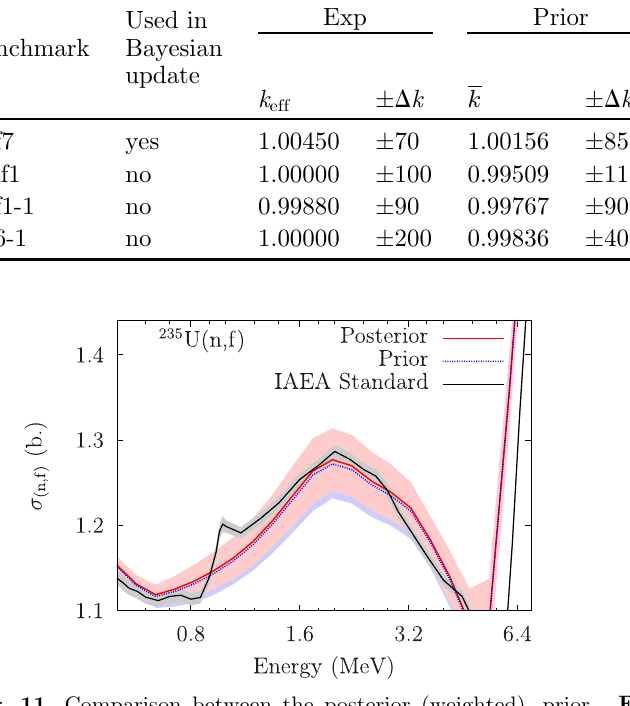
Fig. 11. Comparison between the posterior (weighted), prior (unweighted) and the IAEA standard 235 U(n,f) cross section and evaluated uncertainties (the lines denote the cross sections whereas the bands are the uncertainties).